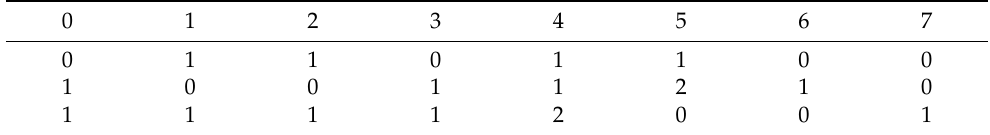
Table 2. The completed Count